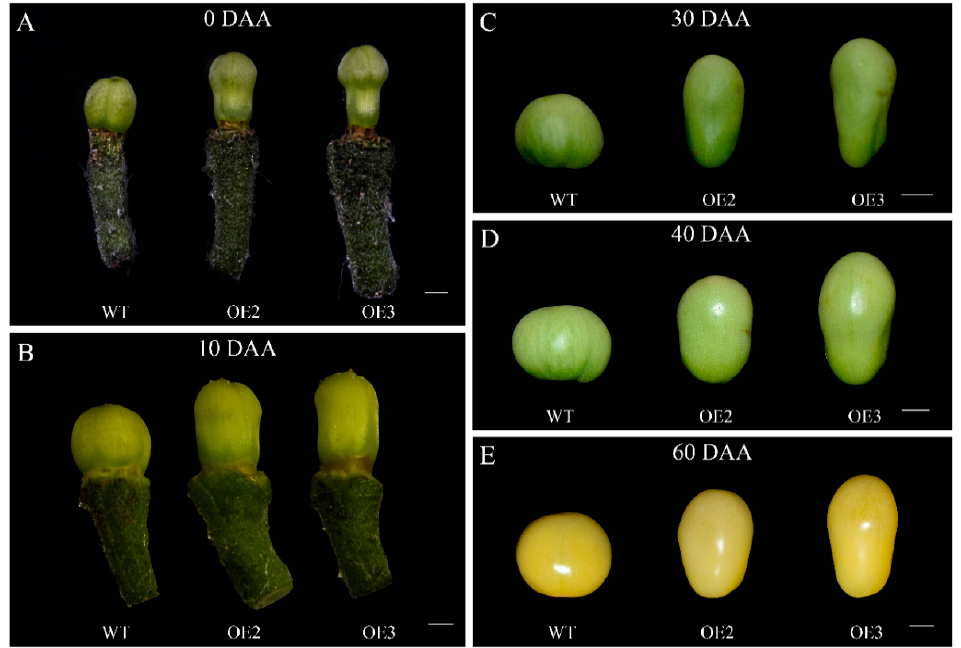
Figure 3. Morphological variations in tomato fruits between wild type plants and transgenic lines. ( A ) Tomato ovaries from wild type (WT) plants and two transgenic lines OE2 and OE3 at 0 days after anthesis (0 DAA). ( B – E ) Tomato fruits from WT, OE2, and OE3 at 10 DAA ( B ), 30 DAA ( C ), 40 ( D ), and 60 DAA ( E ). Scale bars represent 1 mm in ( A , B ) and 1 cm in ( C – E ), respectively.